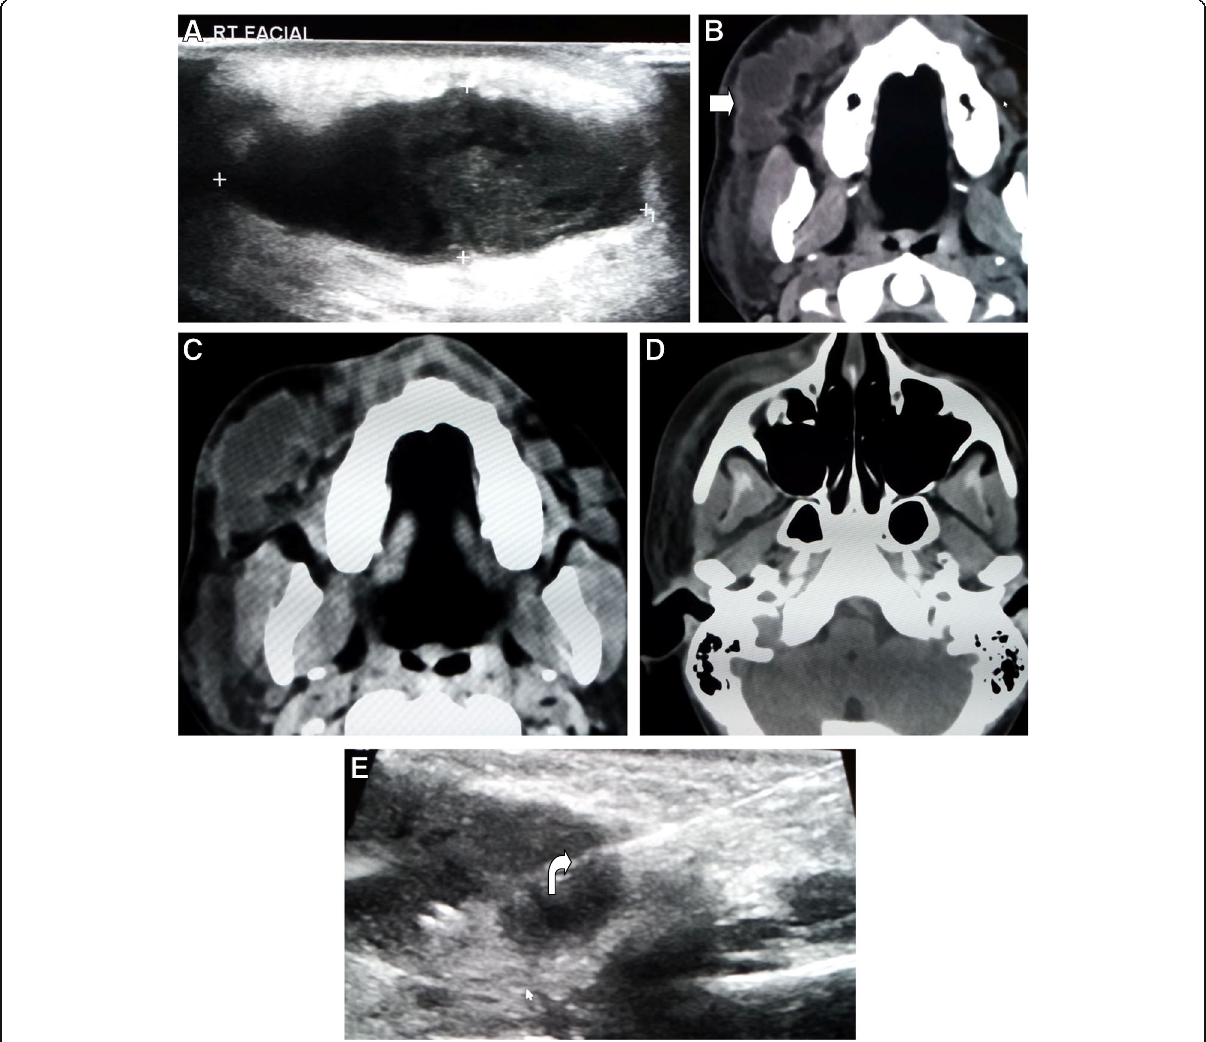
Fig.3 a Sonographic scan of the right side of 35 years old female patient face with pain, signs of infection following filler injection, the transverse scan showed loculated fluid collection with internal echoes. b , c , d Axial CT scans show loculated collection at the anatomical site of the buccal space extending anterior to the masseter muscle with soft tissue swelling inferiorly (arrow). e Ultra sound guided aspiration was done (curved arrow) with aspiration of 10 cc pure pus confirming abscess formation on top of previous filler